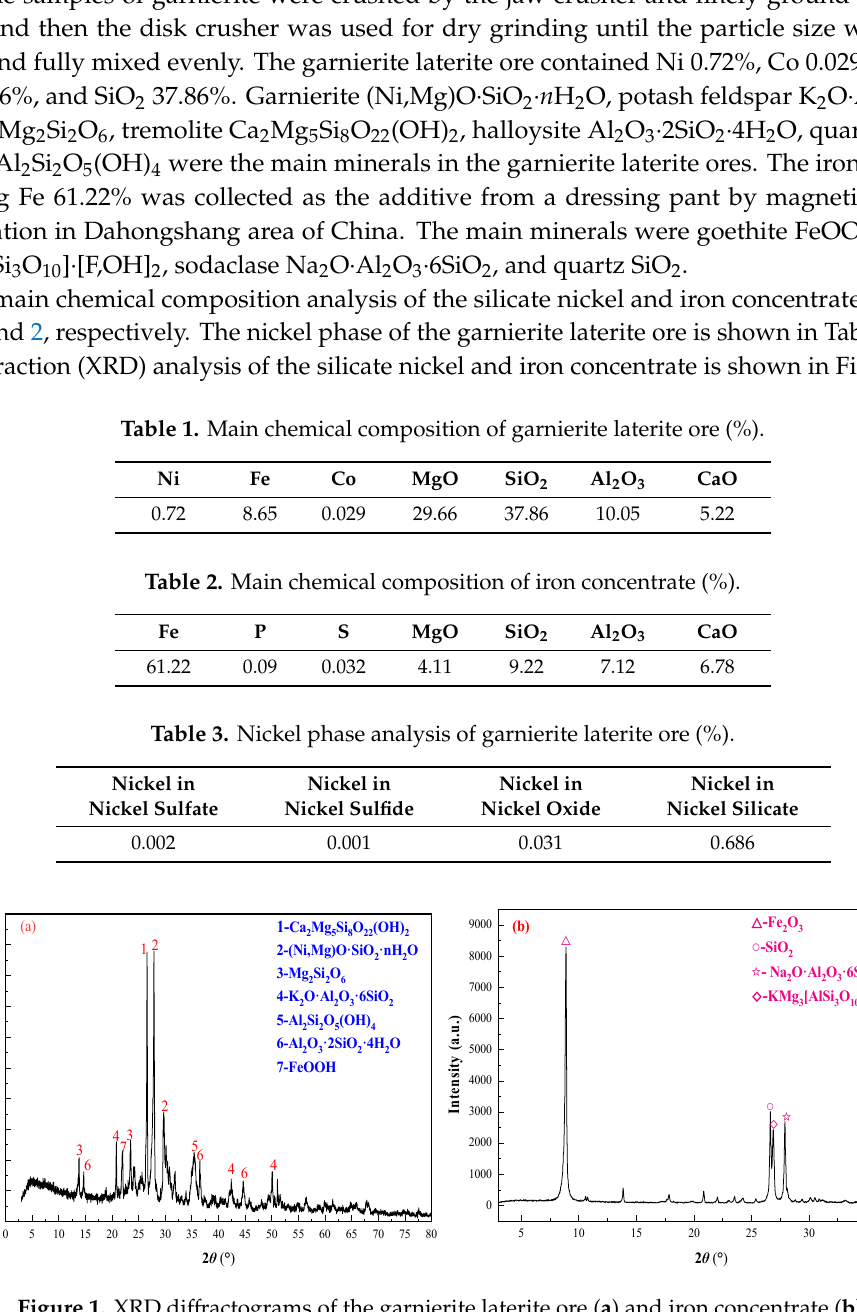
ff ractograms of the garnierite laterite ore ( a ) and iron concentrate ( b Figure 1. XRD diffractograms of the garnierite laterite ore ( a ) and iron concentrate ( b ). Figure 1. XRD di